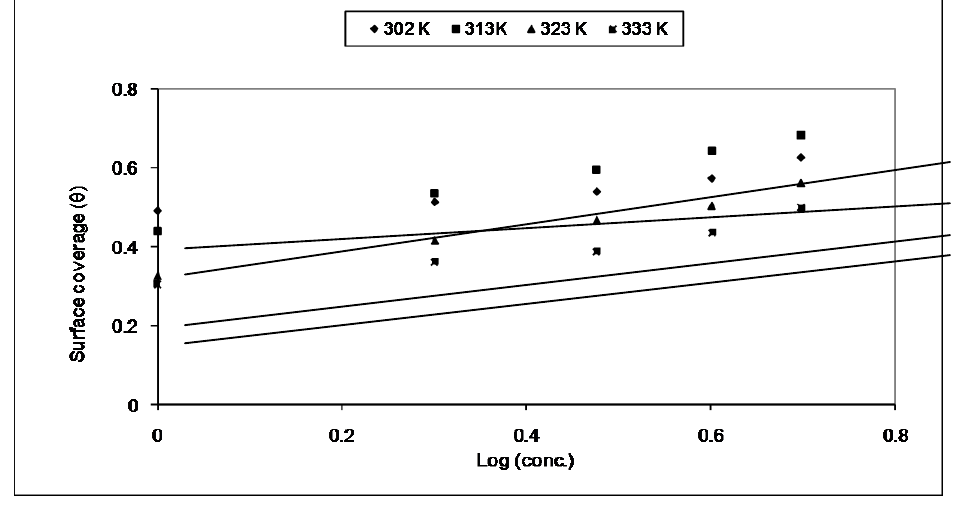
Figure 4 .Temkin’s adsorption isotherm for corrosion behavior of mild steel in 2N Phosphoric acid with Morpholine.